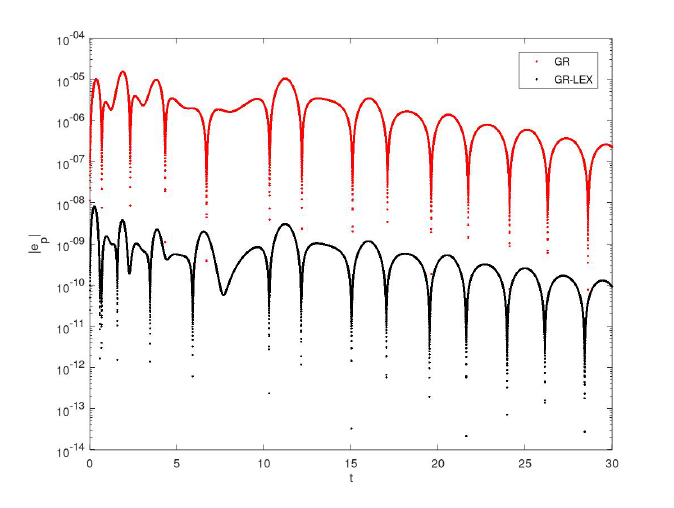
Figure 2. Errors of GR-LEX (black) compared to errors of GR (red) for generic initial conditions x 0 = 2.16, p 0 =